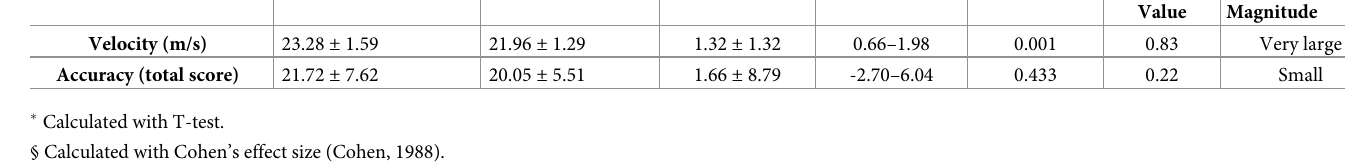
Table 2. Ball velocity (m/s) and mean accuracy in fatigue and non-fatigued conditions (Mean ± SD). Without Fatigue With